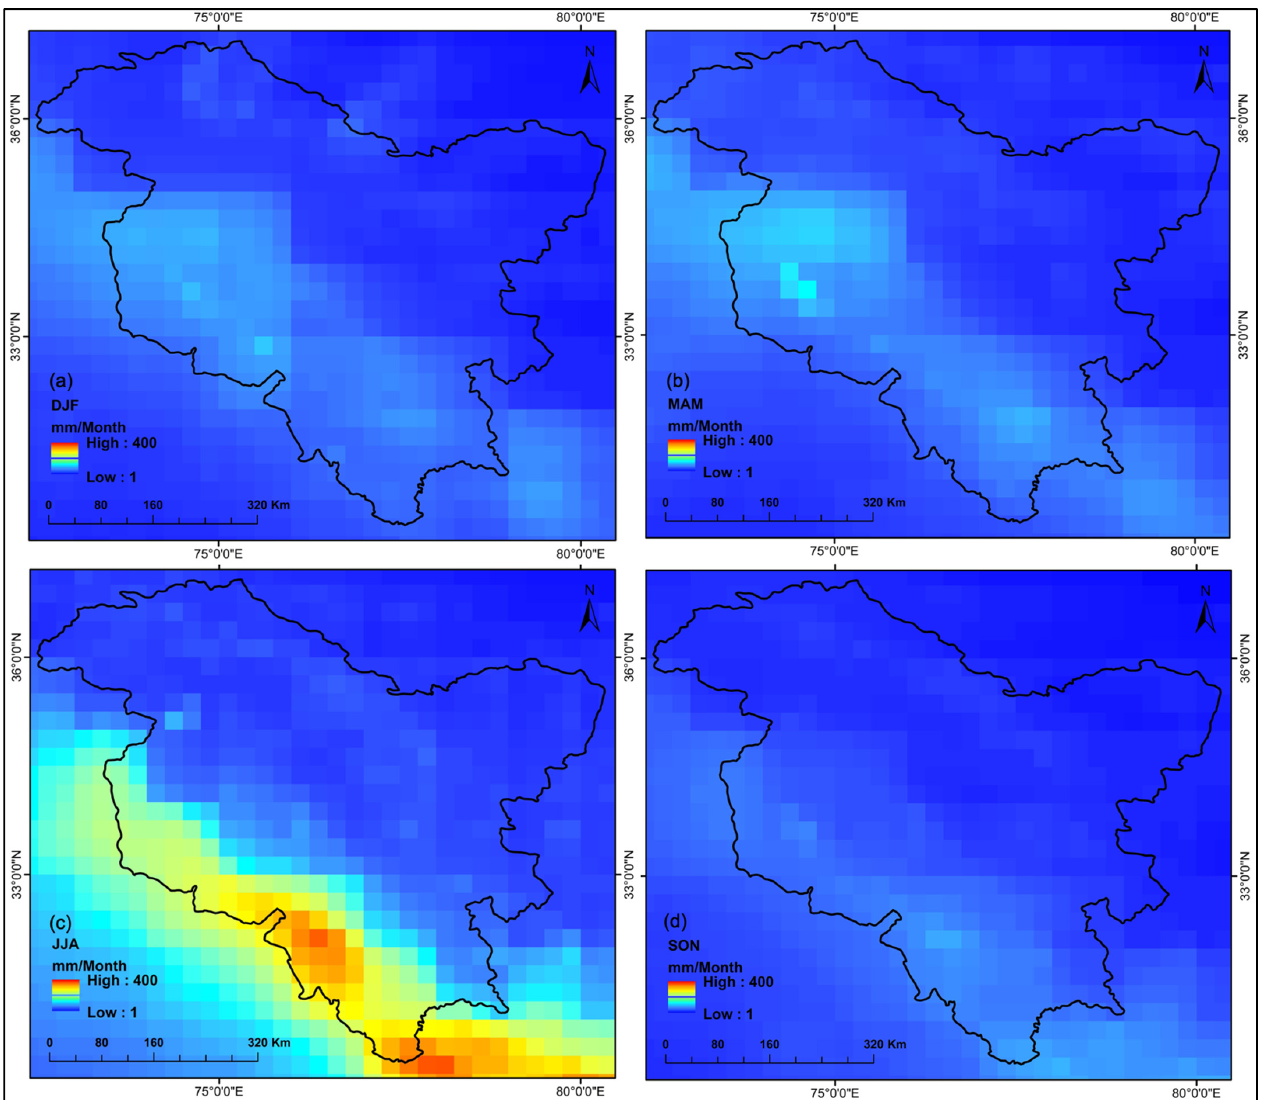
Figure 2. Tropical Rainfall Measuring Mission (TRMM) derived precipitation maps [76] of the study area showing dominance of precipitation during ( a ) December–January–February; ( b ) March–April–May; ( c ) June–July–August and; ( d ) September–October–November.